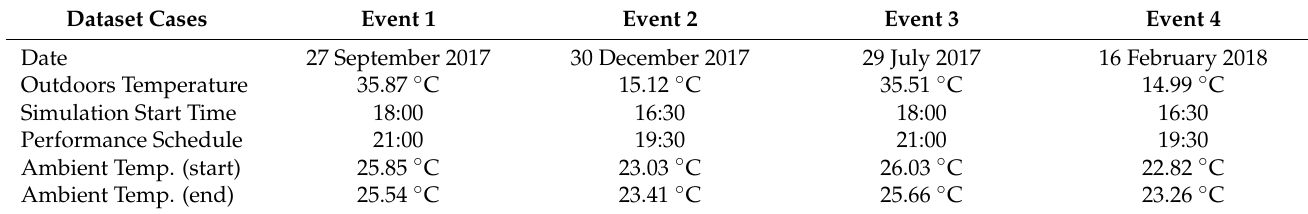
Table 5. Model prediction applying optimal HOMs.